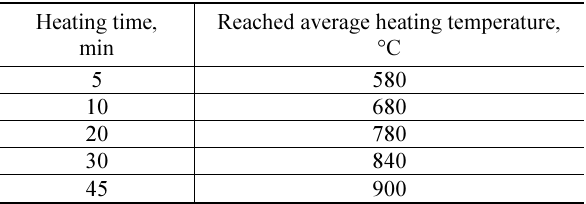
Table 1. The average reached temperature in the heating chamber depending on time Heating time,